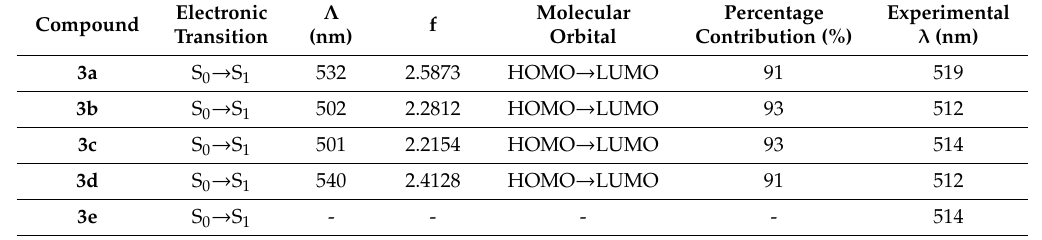
Figure 8. The geometry of compound 3a in the ground and excited states, which was obtained by TD– DFT//B3LYP//6-311+G (d). Table 7. Comparison of a compound’s geometry in the ground and excited states.